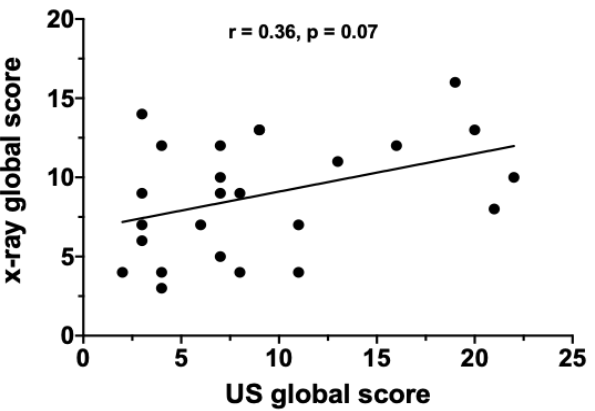
Figure 3. Correlation between lung US global score and X-ray global score in the overall study population.